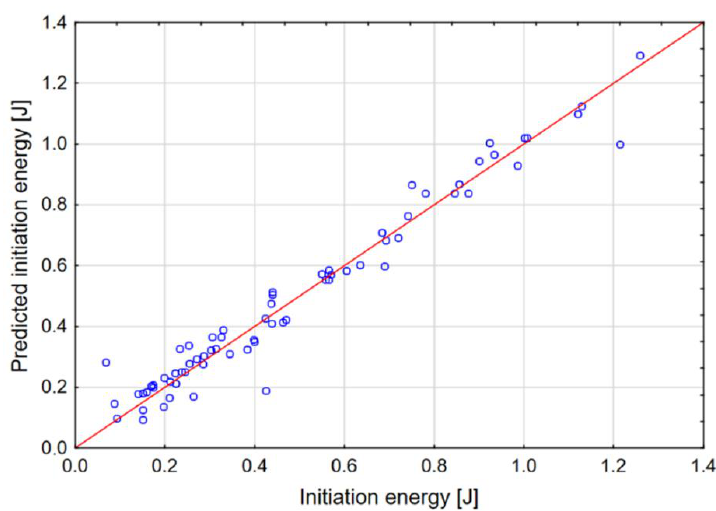
Figure 11. Actual versus predicted values: fracture energy.